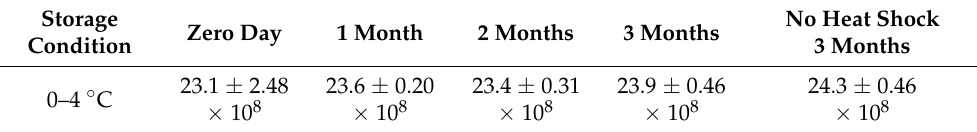
Table 4. Cell viability (in cfu) of developed formulation at different time points.